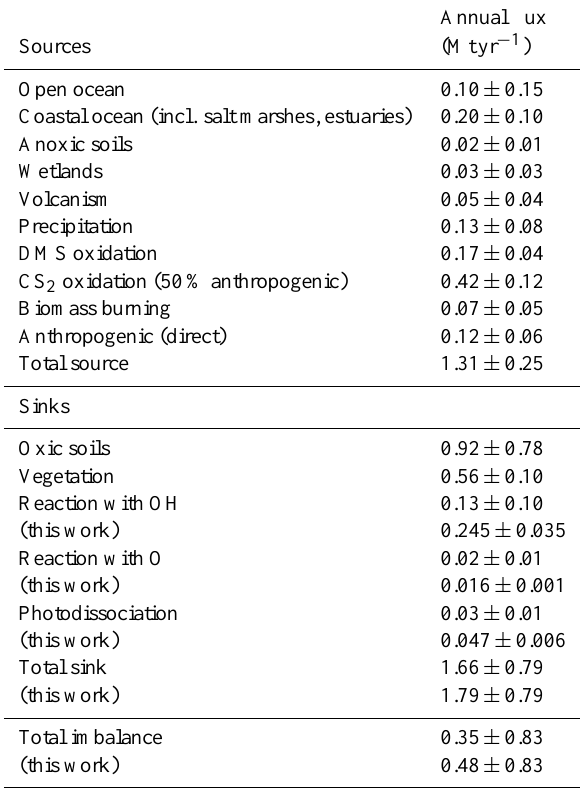
Table 1. Global atmospheric budget of COS after Watts